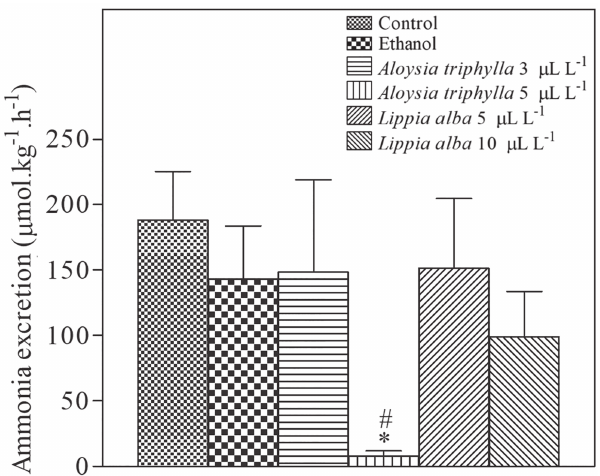
Fig. 4. Ammonia excretion of Serrasalmus eigenmanni exposed to essential oils for 4 hours. a. A. triphylla essential oil. b. L. alba essential oil. * indicates a significant difference from control fish and # indicates a significant difference from ethanol-exposed fish, based on one-way ANOVA and Tukey tests (P <